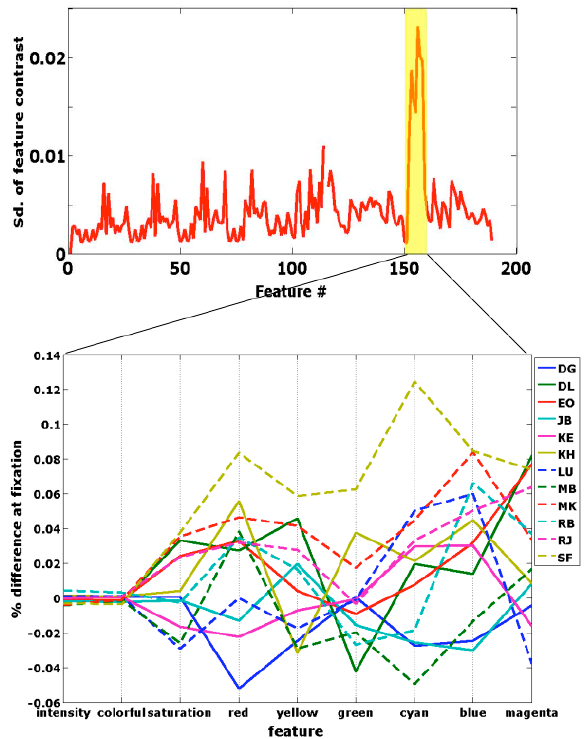
Figure 5. Feature differences, computed according to Formula (1), between fixations during beauty and fixations during roughness. The top shows the standard deviation over subjects for all features. The color features are numbered 150-158 (highlighted in yellow). The bottom graph shows the feature differences per subject for the color